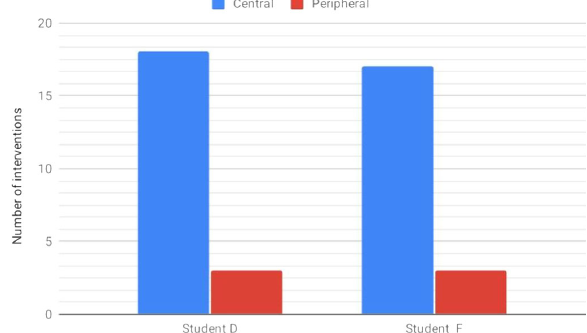
FIG. 11. Type of interventions during segment